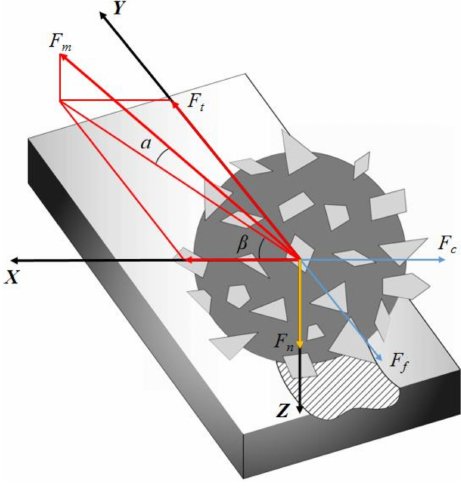
Figure 2. Force state of a single magnetic abrasive